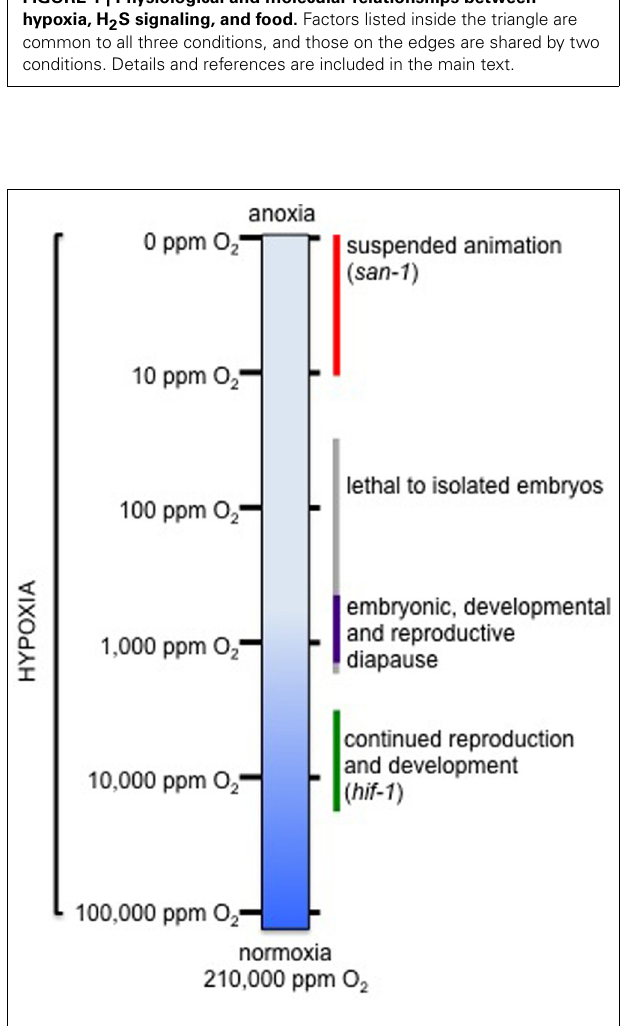
FIGURE 2 | Hypoxia responses at difference concentrations of O 2 . The bar represents decreasing O 2 levels, with normoxia at the bottom and anoxia at the top. For the purposes of this review, normoxia is considered to be room air, which is 210,000 ppm (21%) O 2 . Hypoxia includes all concentrations of O 2 that are less than this. On the right, the physiological response of C. elegans to different O 2 concentrations is noted, as described in the main